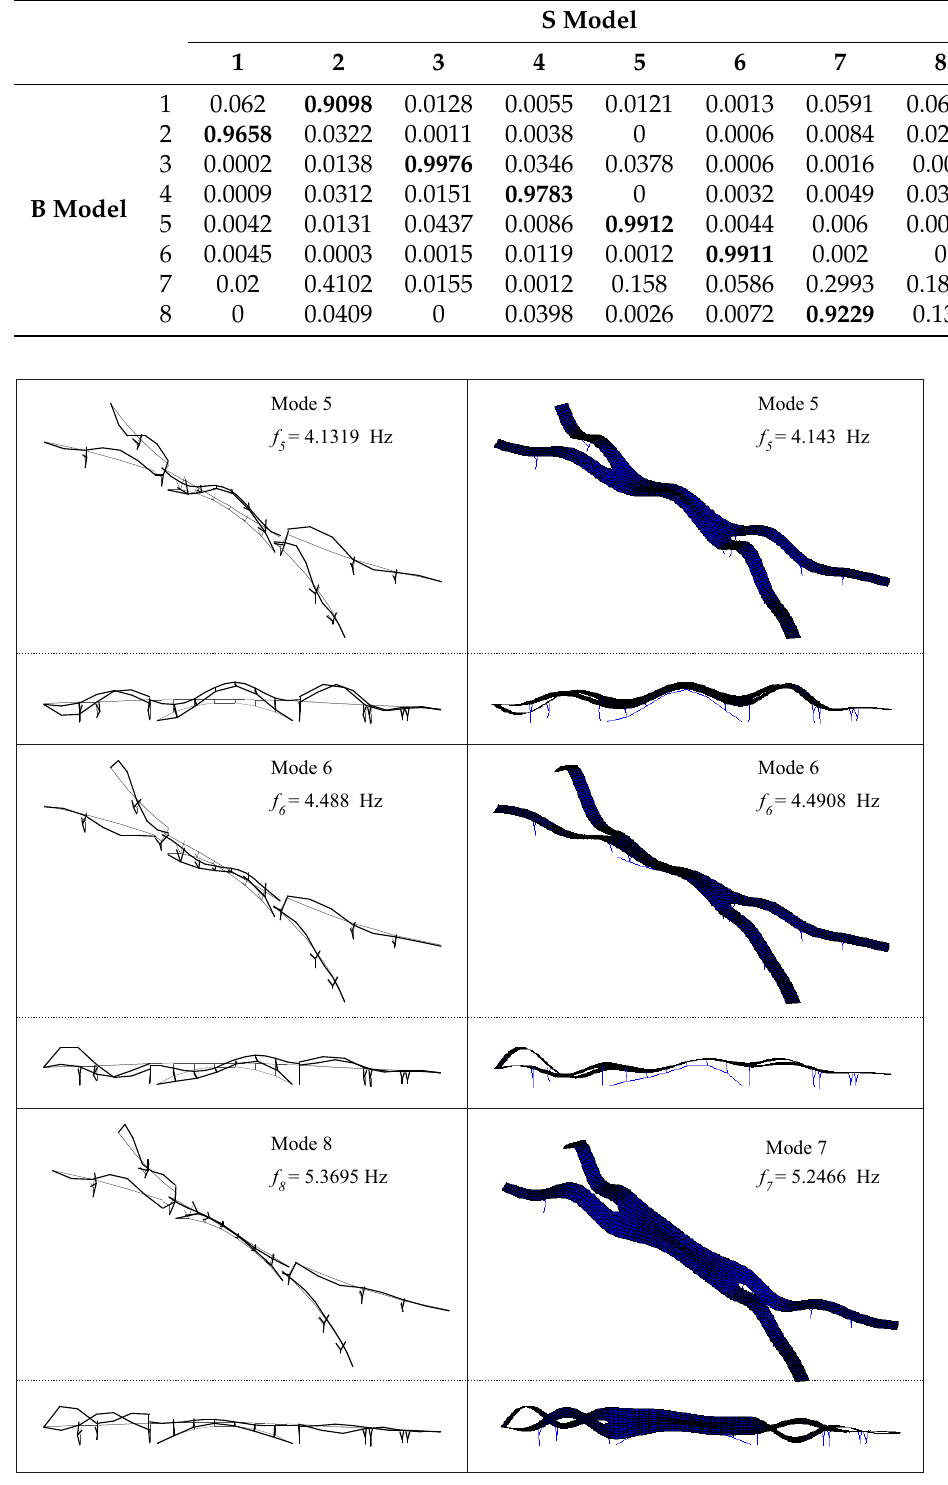
Figure 13. Mode shapes 5 to 8 of B model ( left ) and 5 to 7 of S model ( right